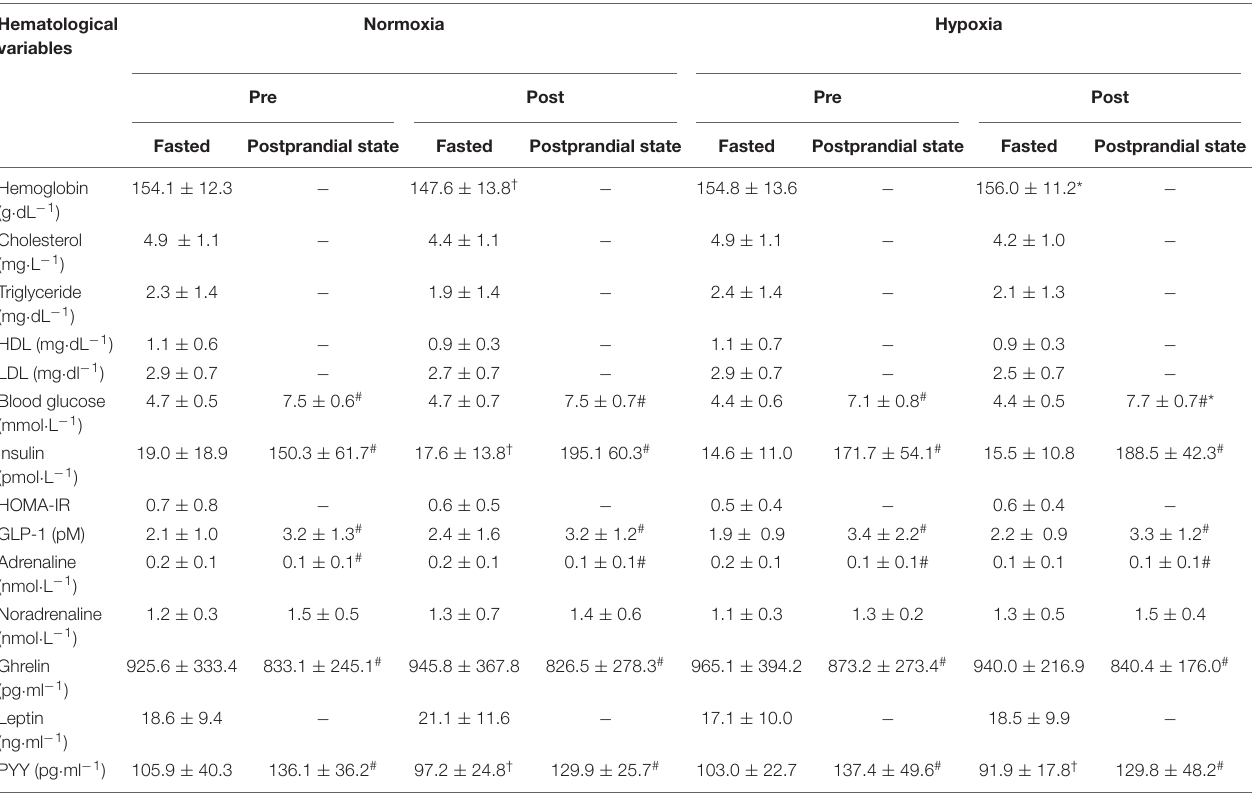
TABLE 2 | Hematological variables in fasted state after the meal before (PRE) and at the end (POST) of the NORMOXIC and HYPOXIC trials. Hematological variables